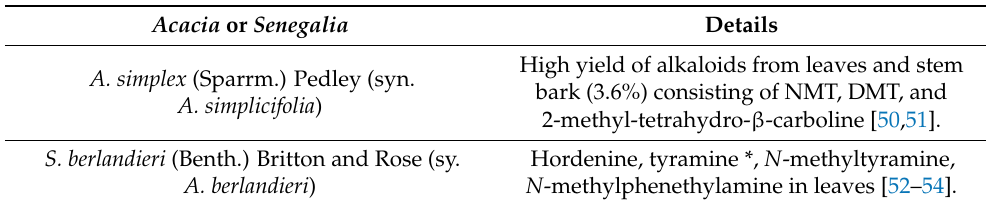
Table 3. Two American species, one from Acacia and one from Senegalia that have sufficient evidence of psychotropic alkaloids according to peer reviewed journal